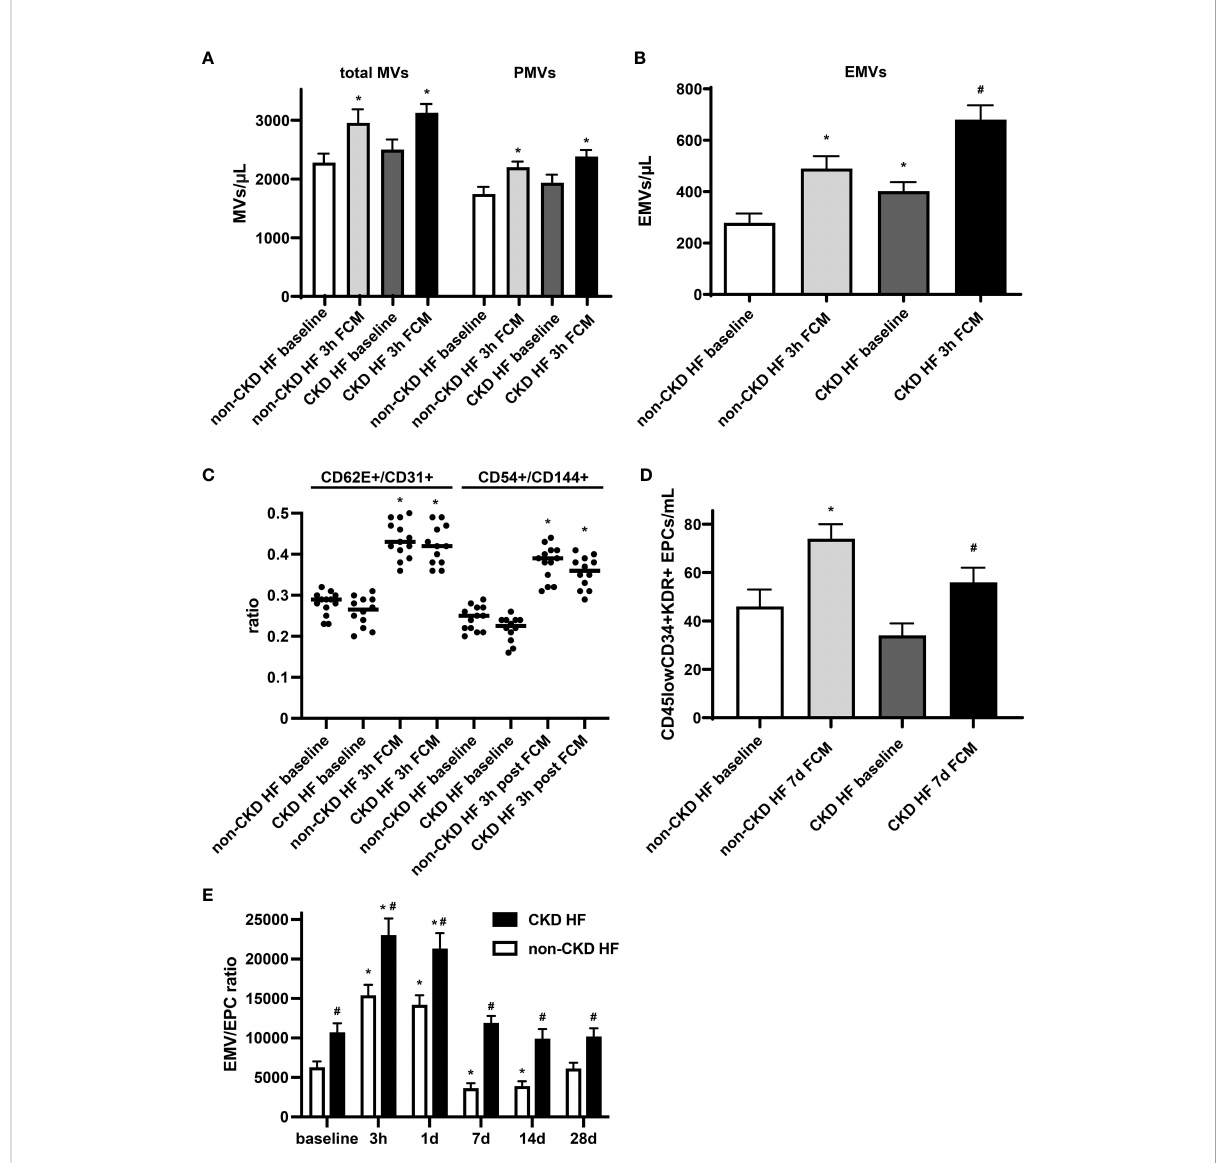
FIGURE 4 Circulating EMVs and EPCs in HF patients with CKD. (A, B) Levels of circulating MVs and their subpopulations in HF patients with or without additional CKD at baseline and three hours after FCM application. *p < 0.05 vs. non-CKD HF patients at baseline, #p < 0.05 vs. non-CKD HF patients three hours after FCM application. (C) EMV CD62E+/CD31+ and CD54+/CD144+ ratio in HF patients with/without CKD. *p < 0.05 vs. the respective ratio at baseline. (D) Assessment of CD45 low CD34 + KDR + EPCs in HF patients with/without CKD at baseline and seven days after FCM application as noted. *p < 0.05 vs. non-CKD HF patients at baseline, # p < 0.05 vs. non-CKD HF patients seven days after FCM application. (E) Time course analysis of EMV/EPC ratio in HF patients with CKD. p < 0.05 vs. the respective ratio at baseline. #p < 0.05 vs. non-CKD HF